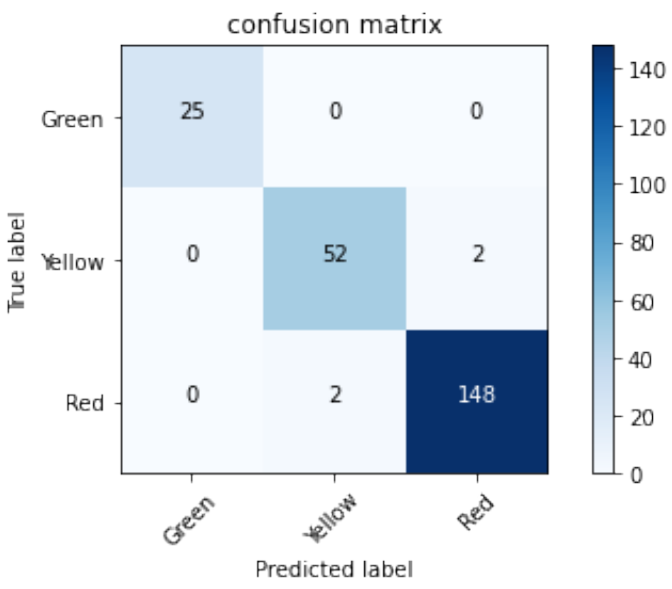
Figure 8. Random Forest confusion matrix on test-set.